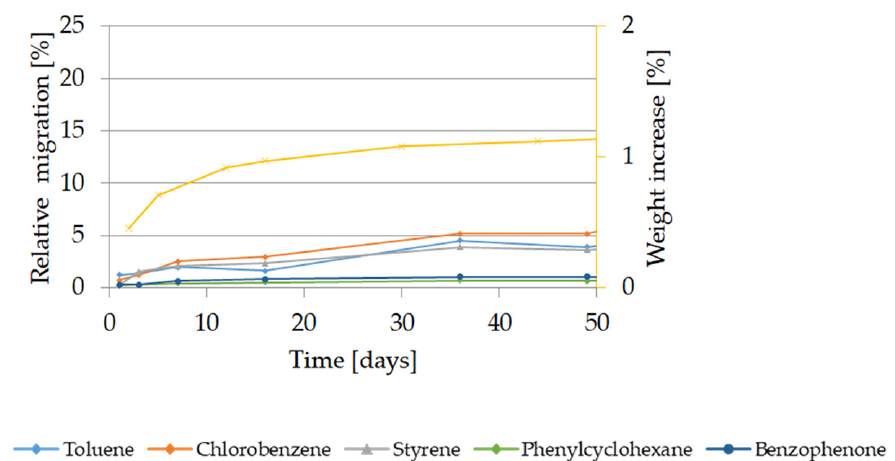
Figure 8. Migration kinetics and weight increase in 50% ethanol at 40 °C: ( a ) Model substances and styrene from GPPS; ( b ) Model substances and styrene from HIPS. Note: Due to analytical interferences, migration of methylstearate from GPPS and HIPS and of phenylcylohexane from GPPS in 50% ethanol at 40 °C can not be measured.